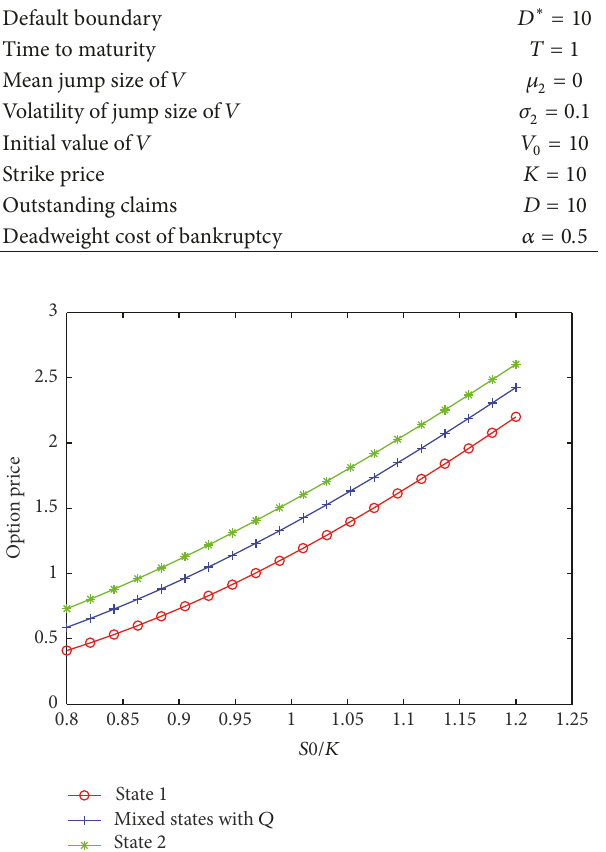
Figure 3: Vulnerable European call option price against mean jump sizes of 𝑆 and 𝑉